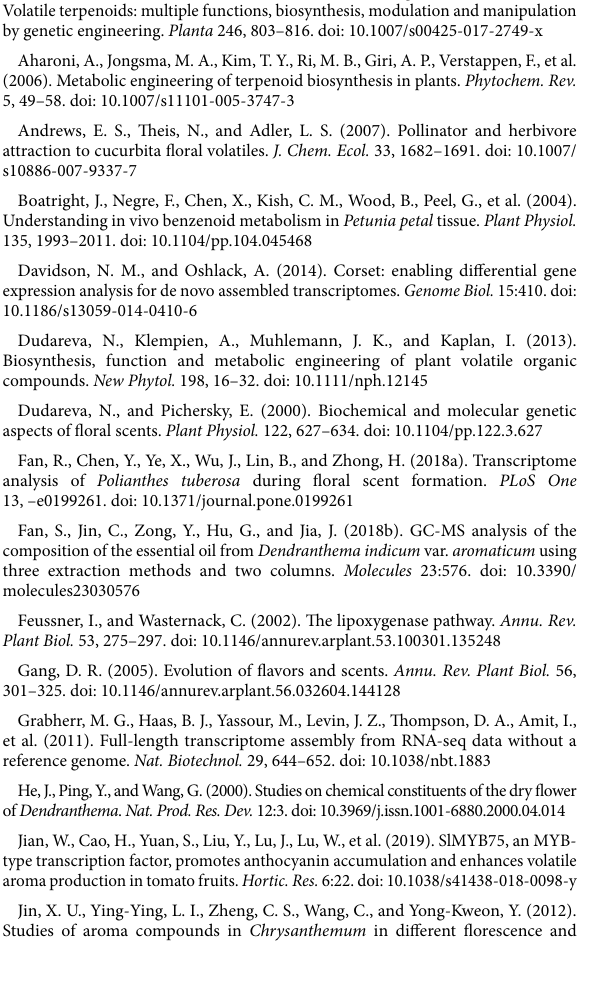
SUPPLEMENTARY FIGURE 1 CIA flowers from different developmental stages: flower bud (FB), initial flower (IF), and blooming flower (BF). SUPPLEMENTARY FIGURE 2 Expression heatmaps of genes detected in flowers of Chrysanthemum indicum var. aromaticum . SUPPLEMENTARY FIGURE 3 KEGG enrichment analyses of DEGs identified in the FB vs . IF dataset. SUPPLEMENTARY FIGURE 4 KEGG enrichment analyses of DEGs identified in the FB vs . BF dataset. SUPPLEMENTARY FIGURE 5 KEGG enrichment analyses of DEGs identified in the IF vs . BF dataset. SUPPLEMENTARY FIGURE 6 qRT-PCR analysis of 12 DEGs chosen from the Chrysanthemum indicum var. aromaticum RNA-seq